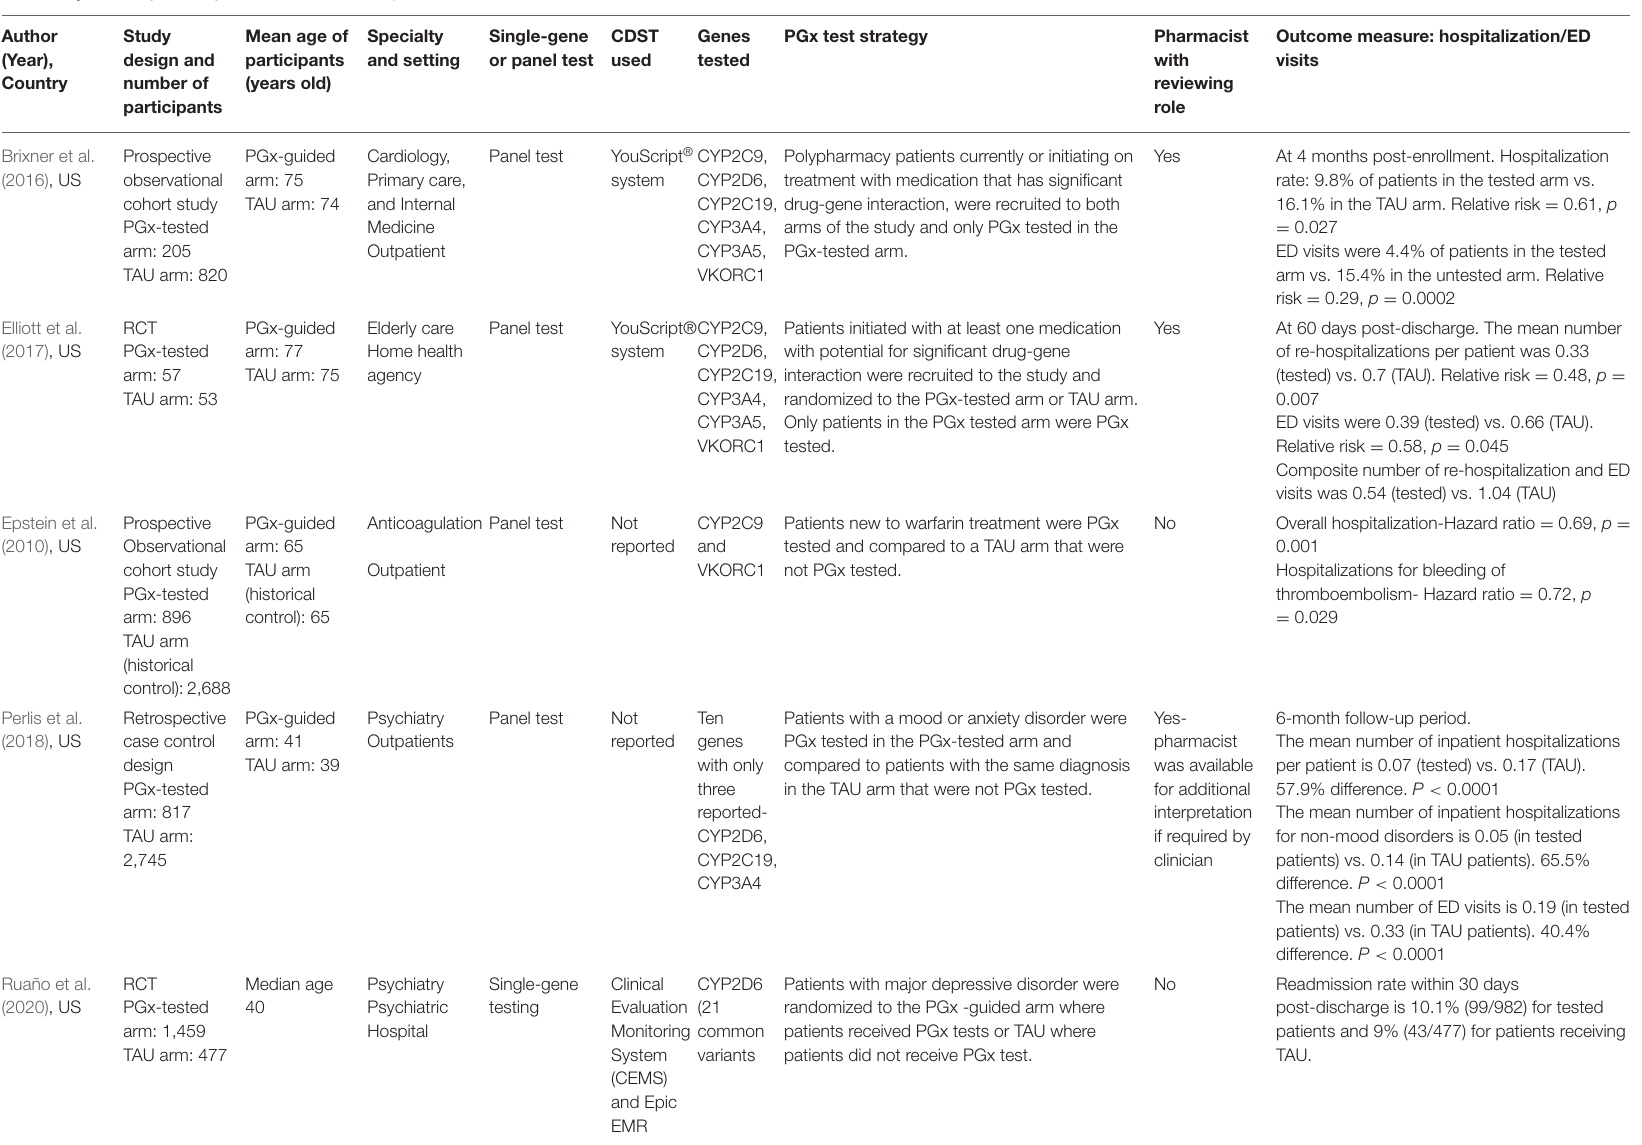
TABLE 4 | Summary of study characteristics for hospital admission